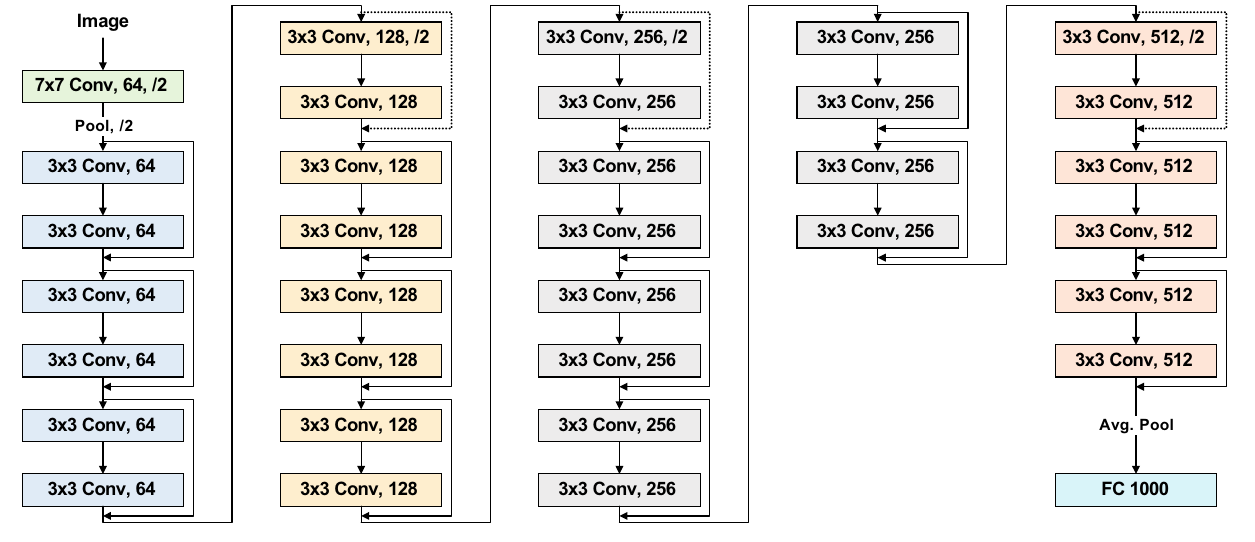
Figure 5. The ResNet-34 model.